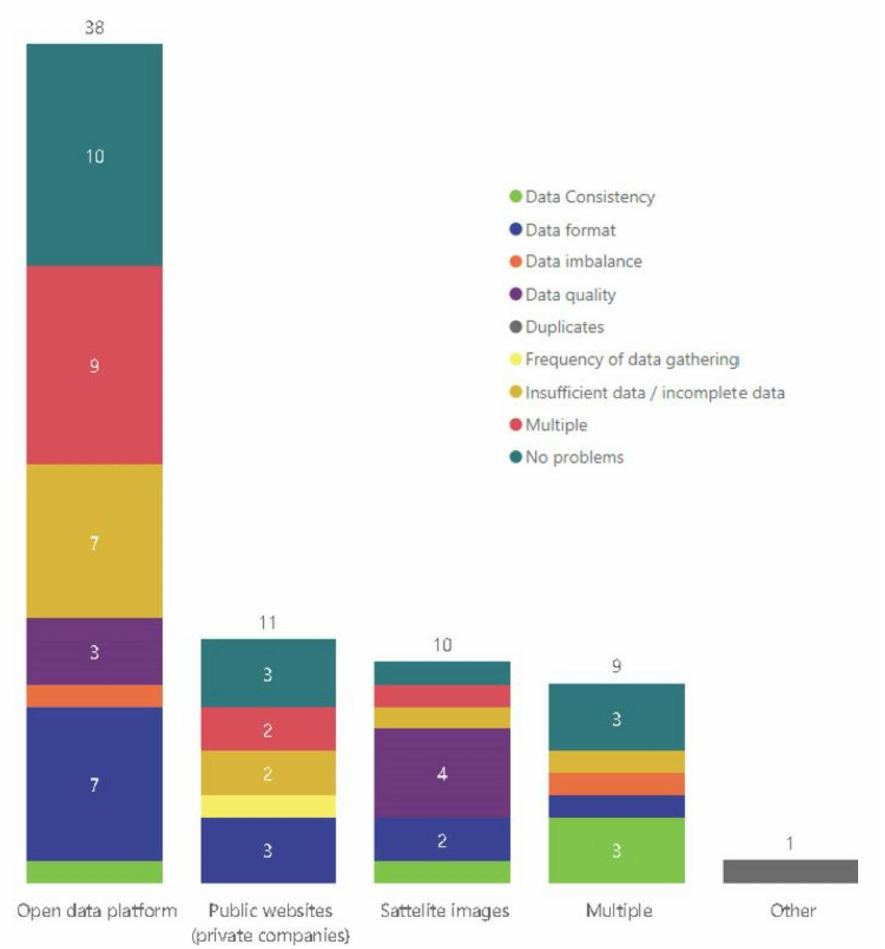
Figure 16. Challenges in open data utilization for each of the OD